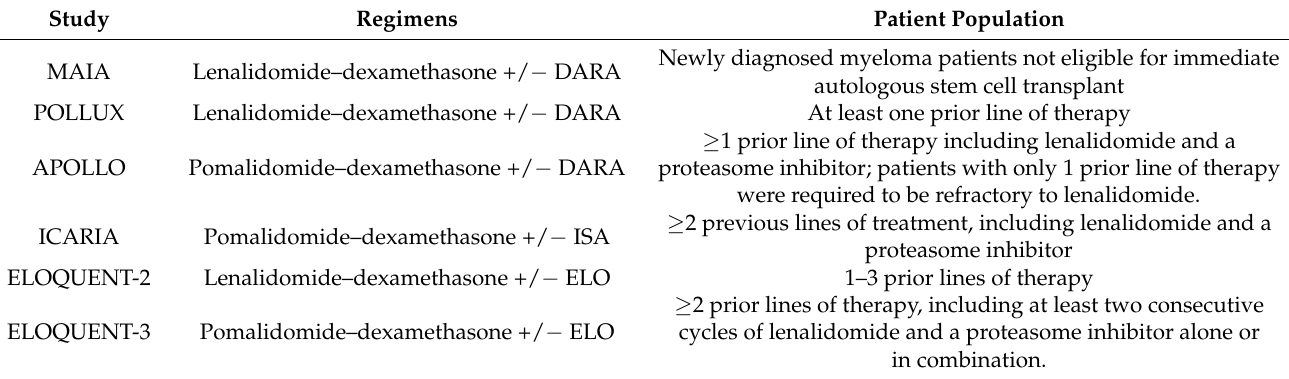
Table 1. Selected phase 3 studies evaluating IMiD-based antibody